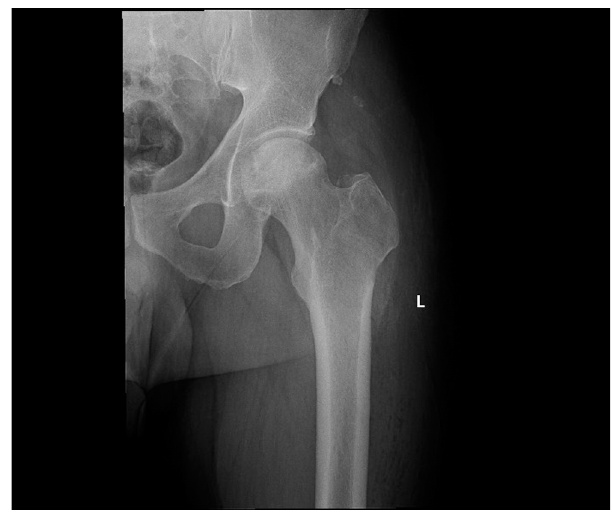
Figure 1. Pre-operative X-ray.